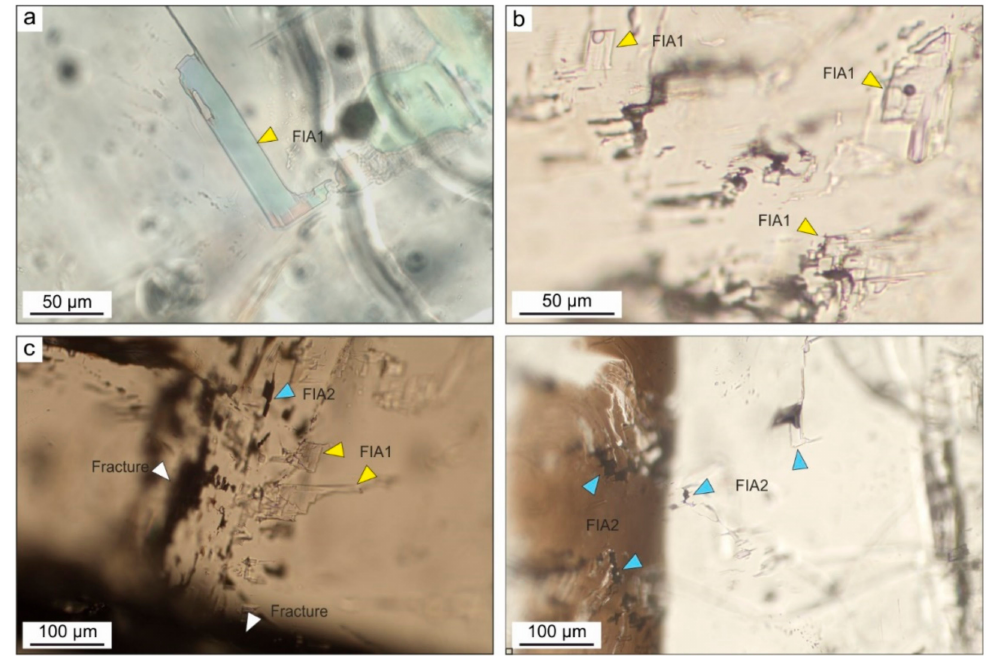
Figure 6. Images from polarizing optical microscope of the main features of fluid inclusions FIA1 and FIA2 (not crossed nicols). ( a ) FIA1 inclusion without gas bubble. ( b ) Very scarce FIA1 inclusions containing gas bubbles. ( c , d ) FIA2 inclusions filled with petroleum. Note how they are arranged parallel to fractures that also contain petroleum.